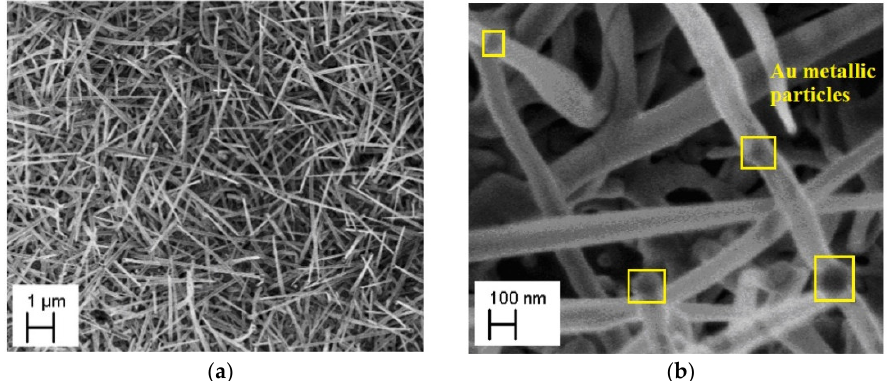
Figure 1. The scanning electron microscopy (SEM) images (in two scales ( a ) 1 µm and ( b ) 100 nm) of vapor phase deposition (VPD) SnO 2 nanowires deposited on Au-covered Si (100) substrate.